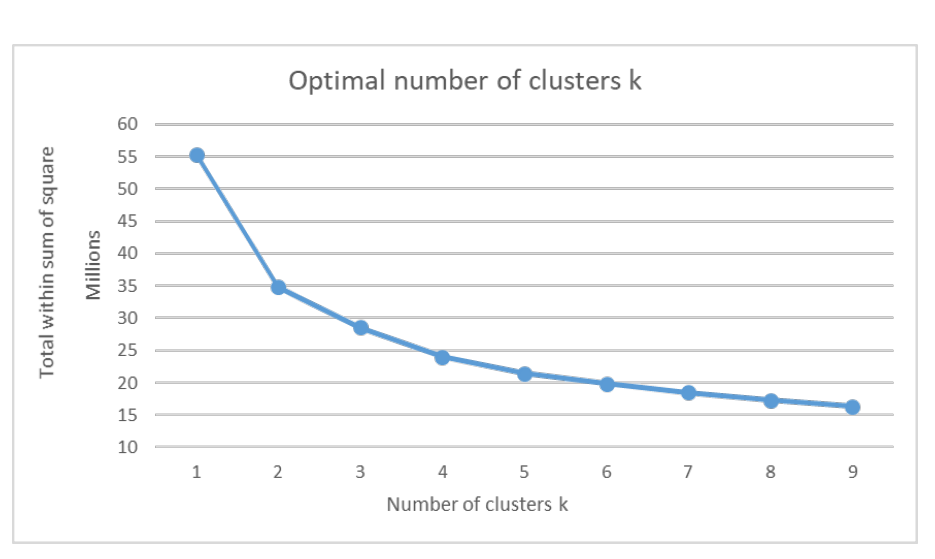
Figure 4. K-Means errors for different K values: Author’s elaboration.